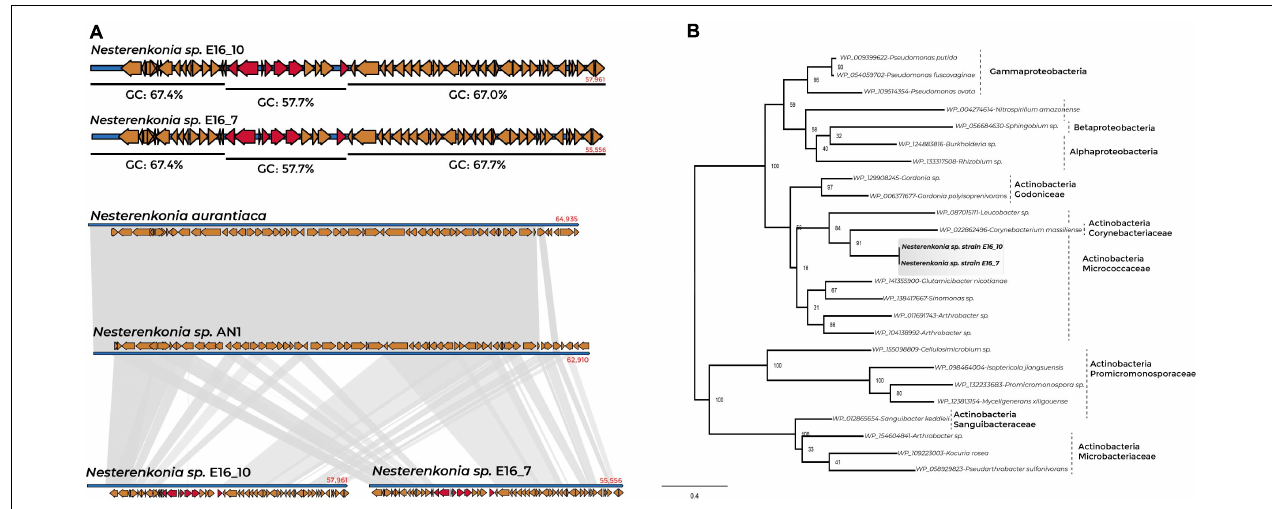
FIGURE 5 | Synteny conservation and phylogenetic tree of pan E gene for sponge-associated Nesterenkonia strains and Actinobacteria members. (A) %GC content of the contig containing the pan E gene of Nesterenkonia E16_7 and E16_10 and genomic organization between sponge-associated Nesterenkonia , N. aurantiaca , and Nesterenkonia AN1. (B) Phylogenetic tree of pan E genes of Nesterenkonia E16_7 and E16_10 and Actinobacteria